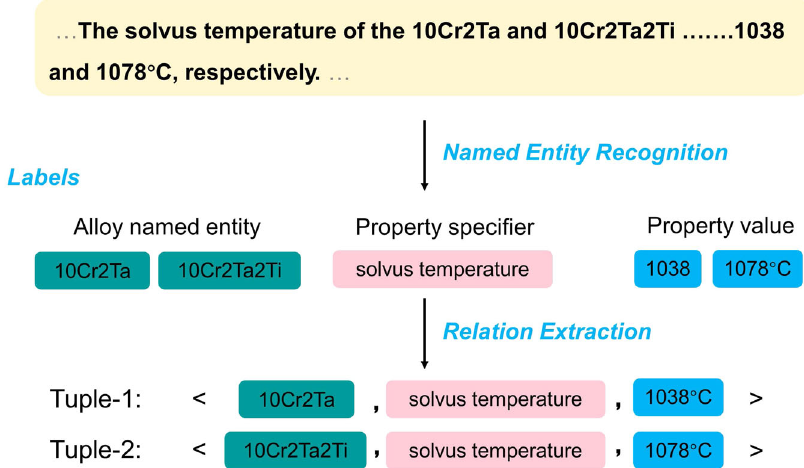
Fig. 2 Named entity recognition technology to provide entity sequence for subsequent relation extraction. The alloy named entity, property speci fi er, and property value are recognized as entity sequence from English-language text and table.